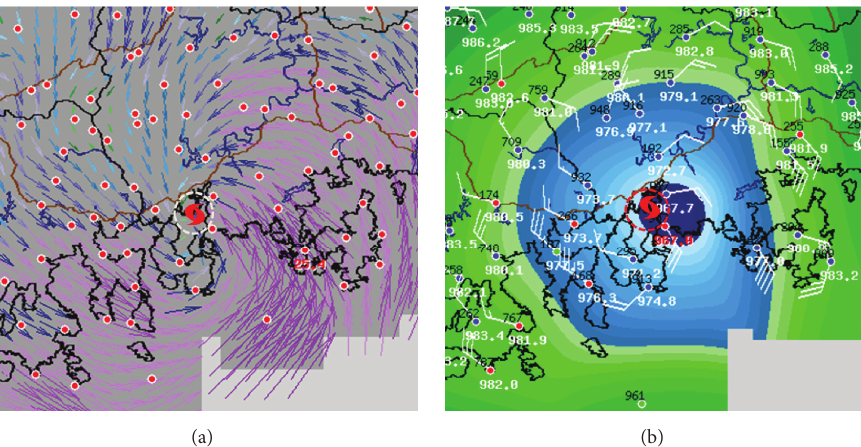
Figure 9: The PIs (circles) and the estimated centers (markers) of Typhoon SANBA (1216) at 06 UTC 17 September, 2012, using domestic synoptic data (including AWS): (a) wind vector and sea level pressure (SLP) (b).